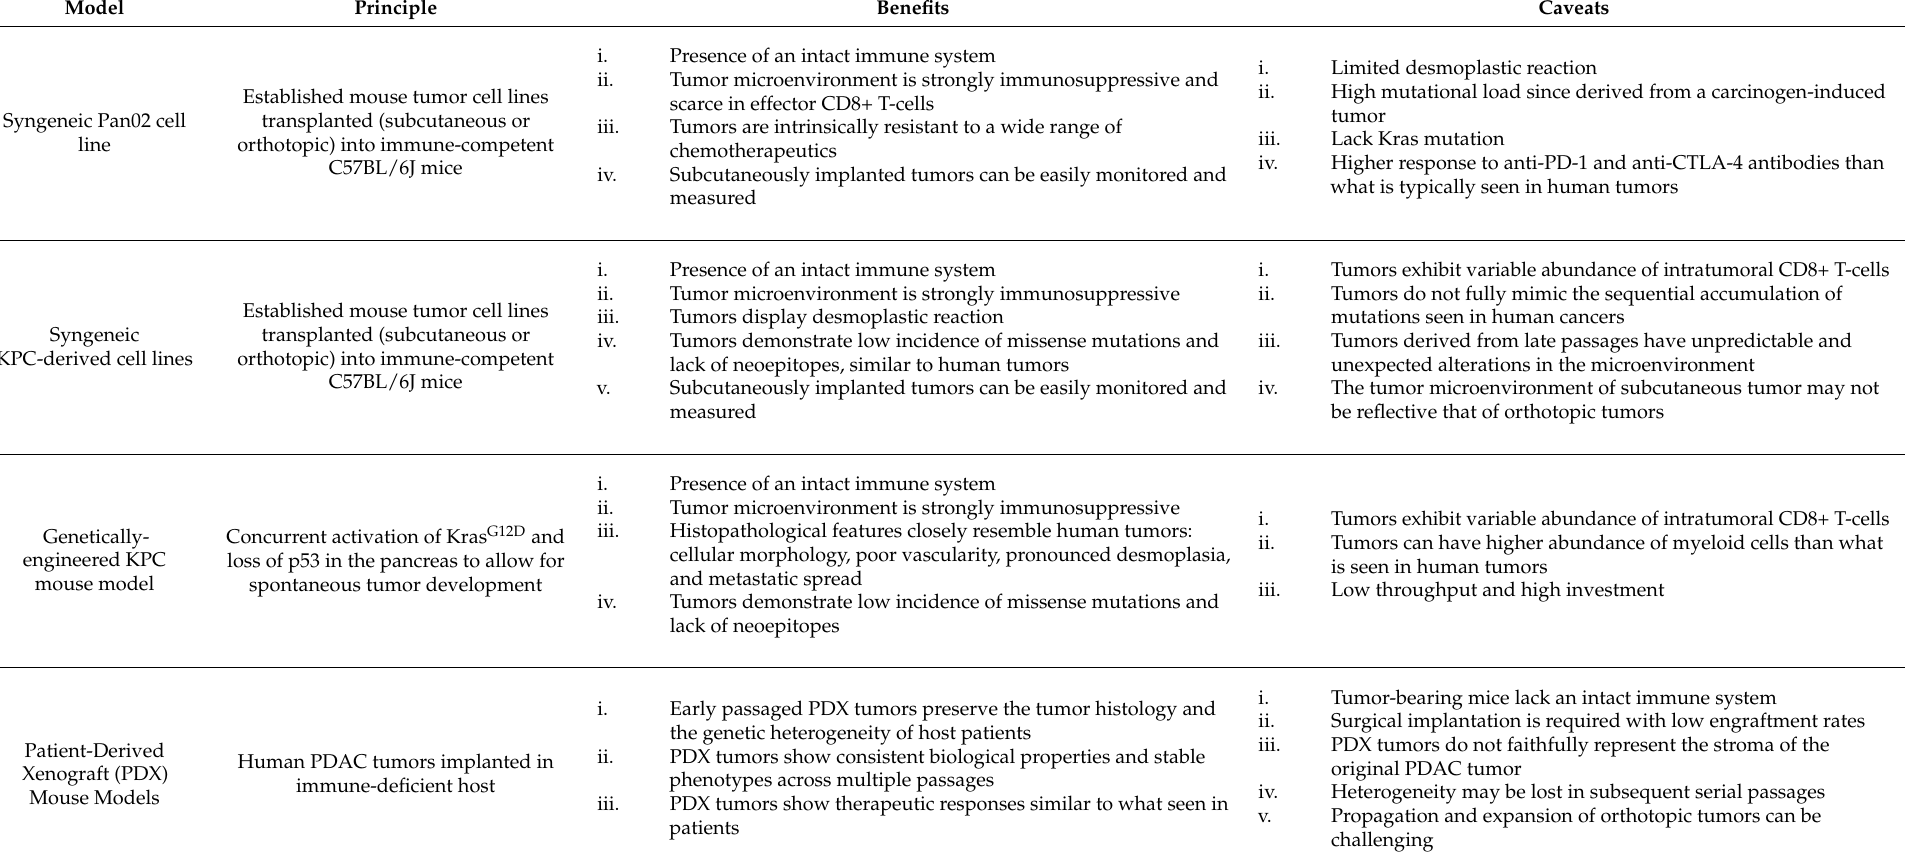
Table 1. Advantages and drawbacks of different preclinical models of PDAC for immunobiology